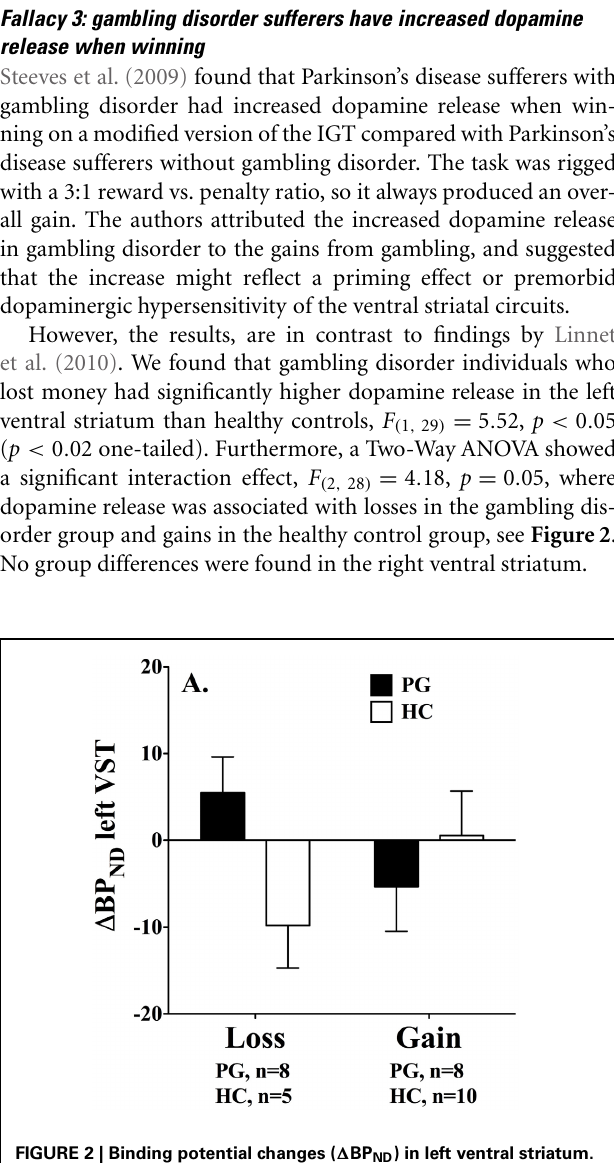
FIGURE 2 | Binding potential changes ( (cid:2) BP ND ) in left ventral striatum. Gambling disorder sufferers who lose money (PG, black bar, n = 8) have significantly higher dopamine release in the left ventral striatum than healthy controls (HC, white bar, n = 5). Gambling disorder sufferers who win money (PG, black bar, n = 8) do not differ in dopamine release from healthy controls (HC, white bar, n = 10). Mean and Standard Errors are illustrated in the bars and error bars, respectively. Dopamine release results in positive values because raclopride binding potentials decrease from baseline to gambling condition (baseline > gambling = positive value). Conversely, dopamine inhibition results in negative values because raclopride binding potentials increase from baseline to gambling condition (baseline < gambling = negative value). Reprint with permission from Linnet et al.